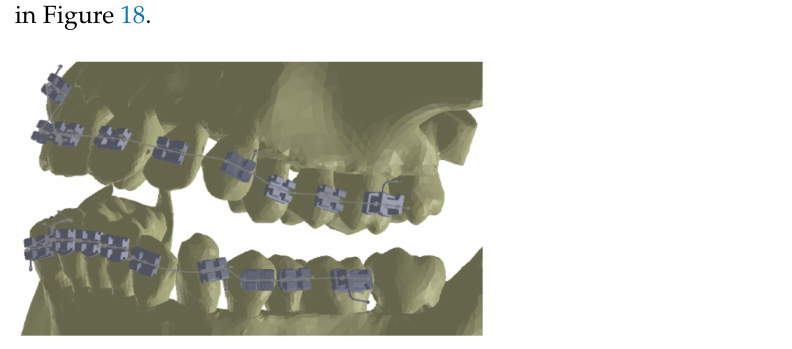
Figure 18. Path base curves generated for the two orthodontic